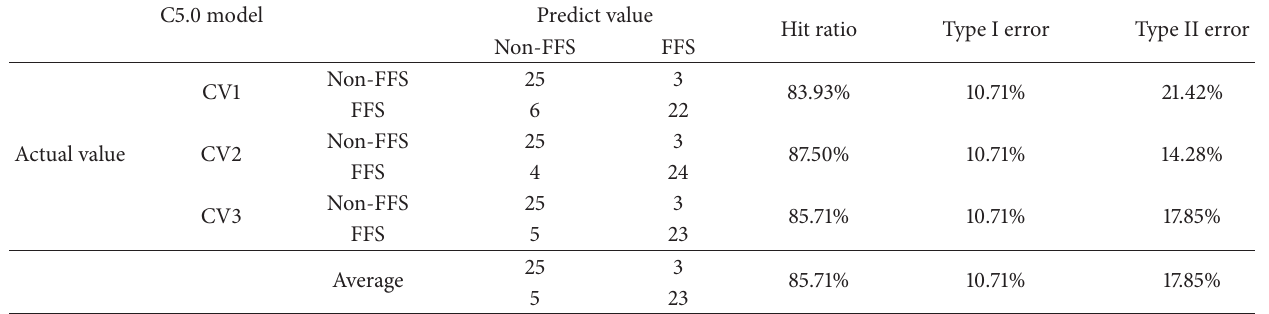
Table 3: C5.0 cross-validation results.